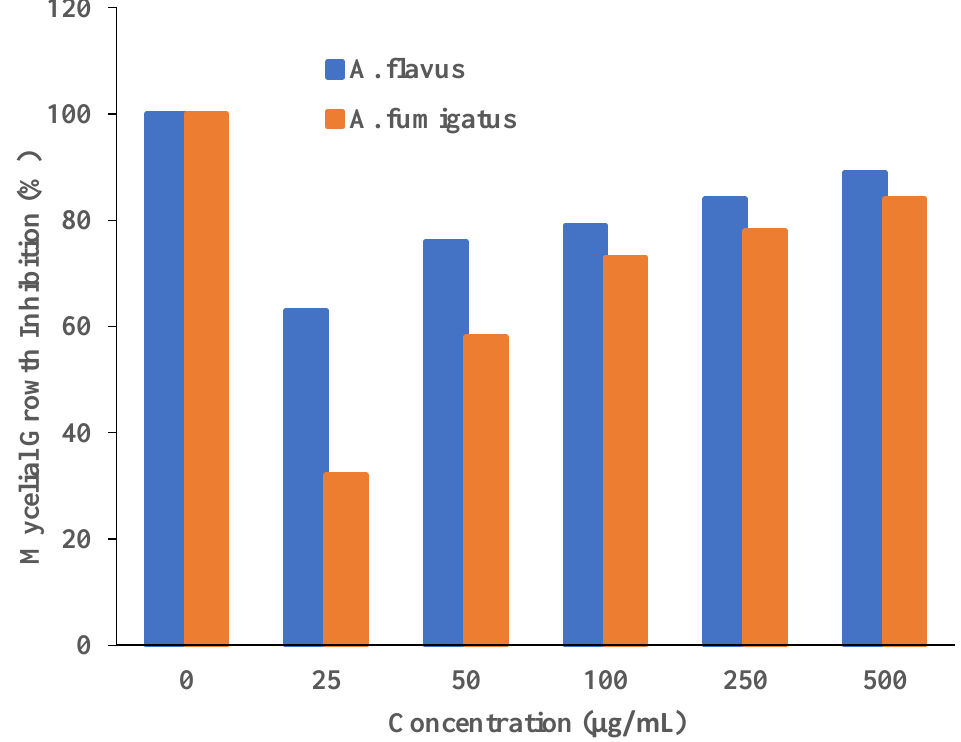
Figure 8. Plots of T-rGO concentration ( µ g/mL) vs. the activity that inhibits mycelial growth (percent). The obtained inhibitory concentrations are around two times lower than those of